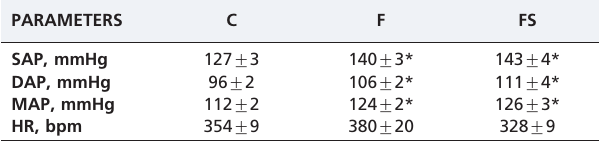
Table 1 - Evaluation of cardiovascular function of the control (C), fructose (F), and fructose + simvastatin (FS) groups.